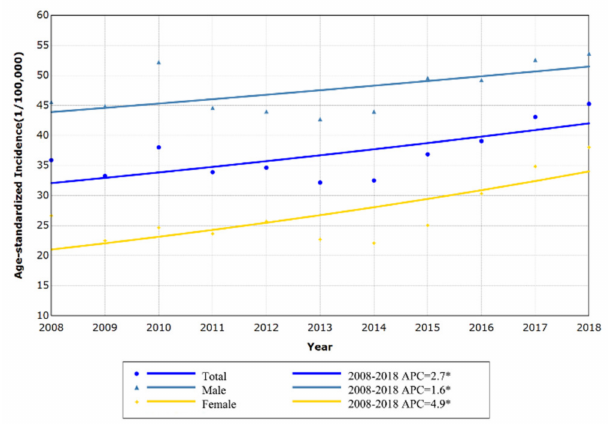
Figure 4. The trend of age-standardized incidence of lung cancer in Shenzhen, 2008–2018.